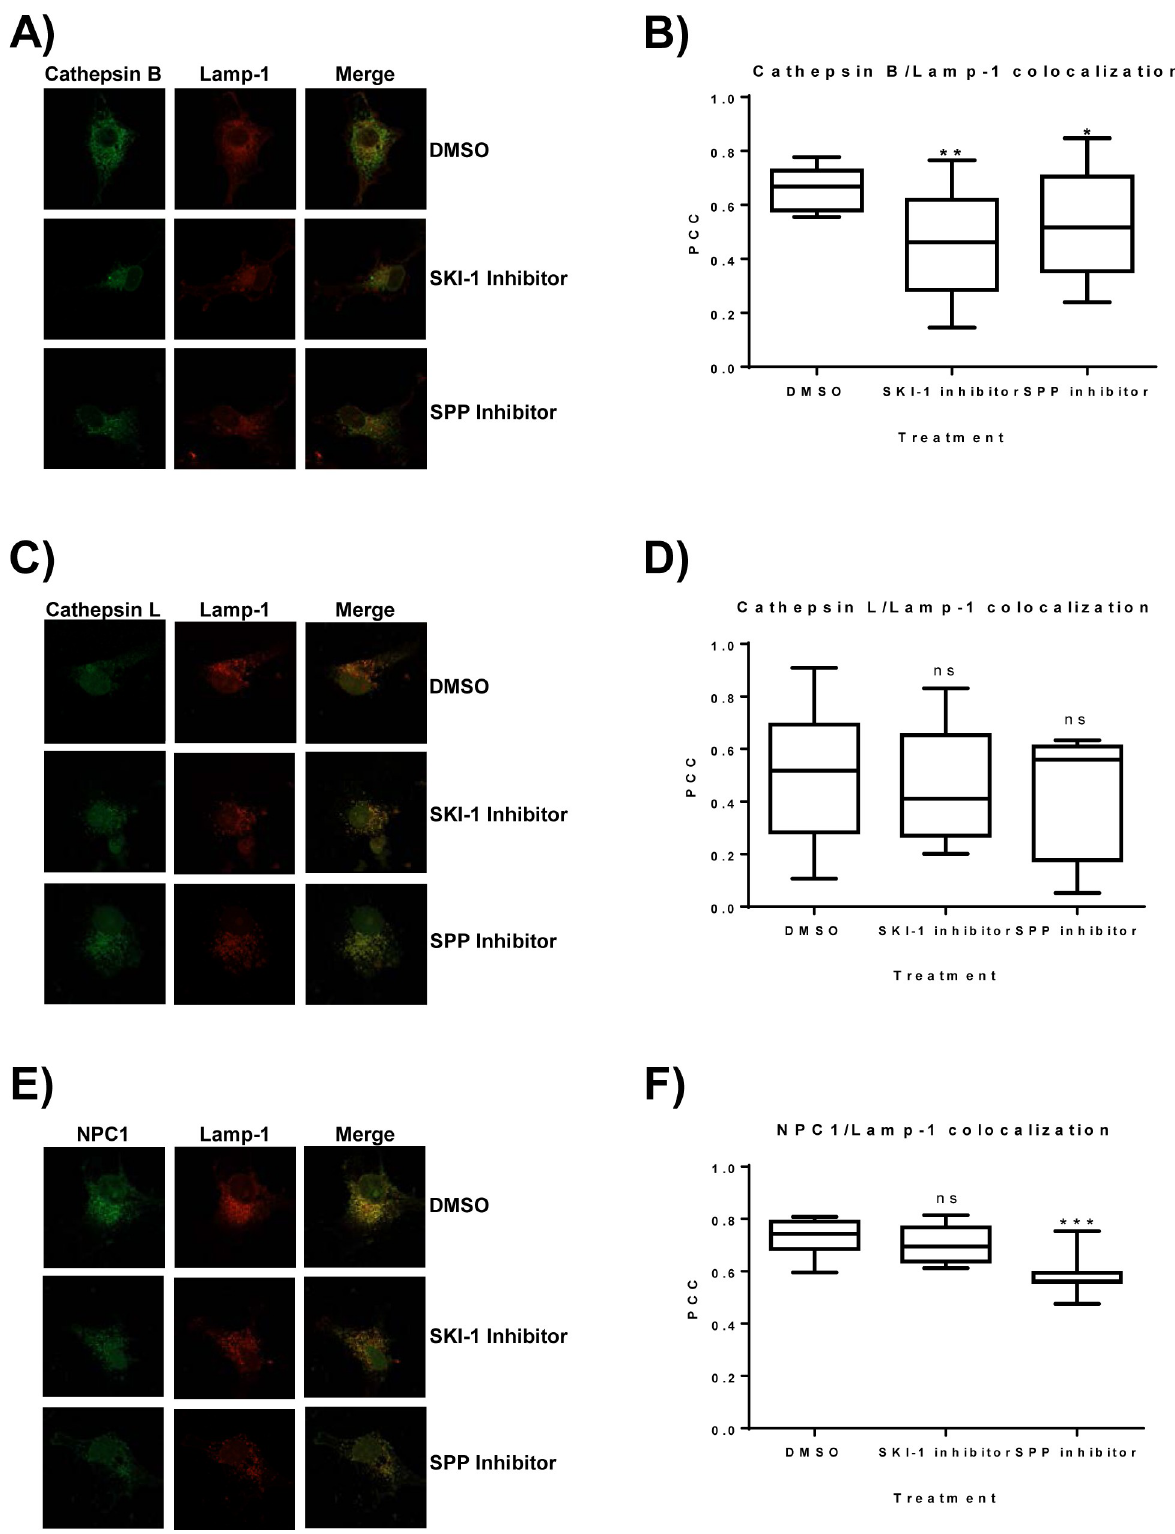
Fig 5. SKI-1 inhibitor disrupts the colocalization of CatB with Lamp-1. COS-7 cells were seeded on glass coverslips and cotransfected with plasmids encoding CatB, CatL or NPC1 all carrying a FLAG-tag and the late endosome/lysosome marker protein Lamp-1 fused to mScarlet. At 4 h